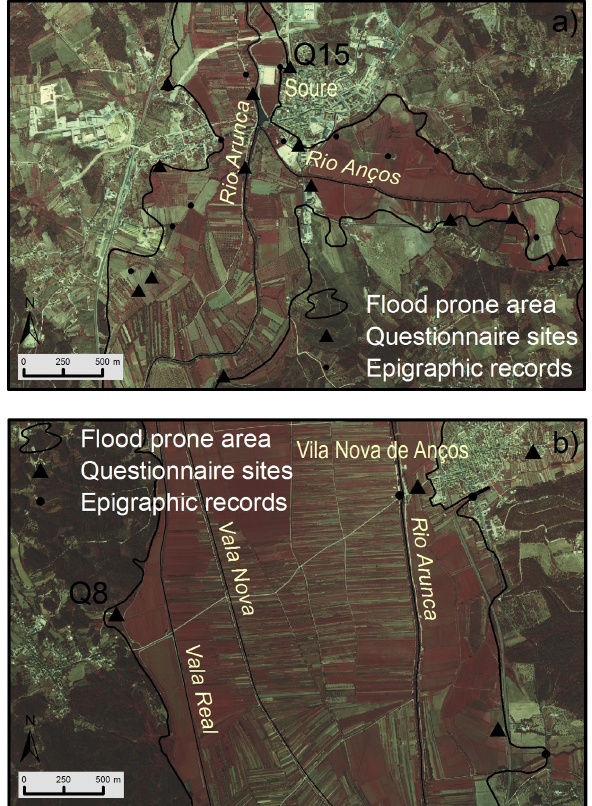
Fig. 4. Examples of field data collection. Water heights during last major flood event (2006) were 0.15m in questionnaire site Q15 (a) and 1.5m in Q8 (b)